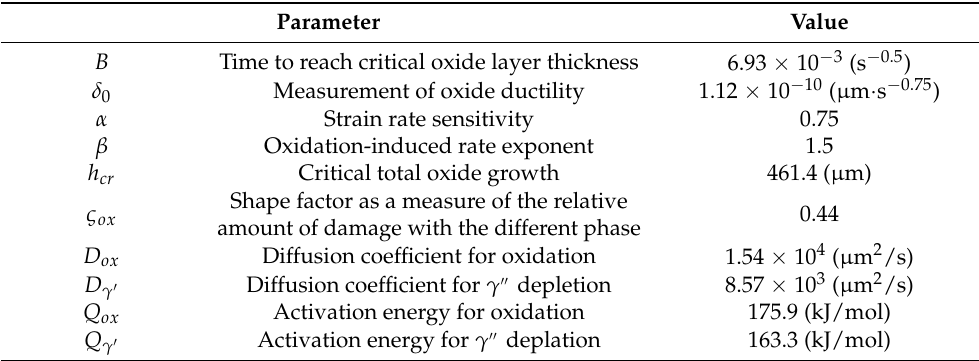
Table 1. Oxidation damage variables presented by Sehitoglu for Mar-M247, adapted with permission from Ref. [16]. Copyright 1990, American Society of Mechanical Engineers.